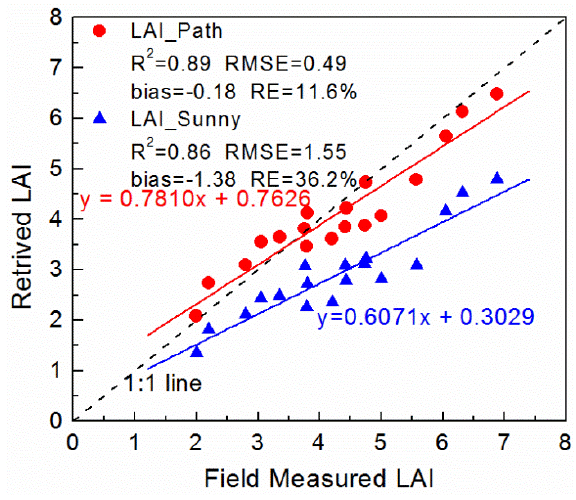
Figure 11. Comparison between retrieved LAI and the corresponding Relative Error (RE) by 18 images acquired on sunny days with field measured true LAI by LAI-2000 and TRAC at the Huailai site in 2014. LAI_Path is the retrieval of LAI by the sunlit foliage component under sunny conditions with the clumping index estimated by the path length-based method, and LAI_Sunny is the retrieval of LAI by the directional gap fraction model under sunny conditions with the clumping index estimated by the widely used Lang and Xiang (LX)